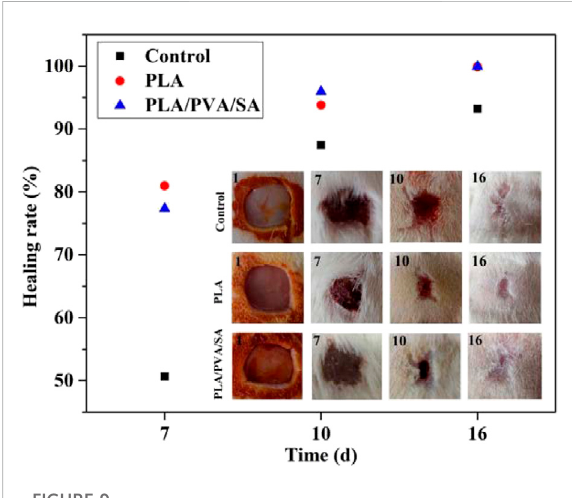
FIGURE 9 Healing rate and wound closure imageofPLA fi ber treatment and PLA/PVA/SA fi ber treatment (Bi et al.,